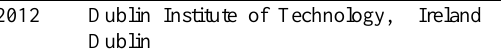
Table 1. EduServ Host Organisations (Vanden Berghe & Mooney,